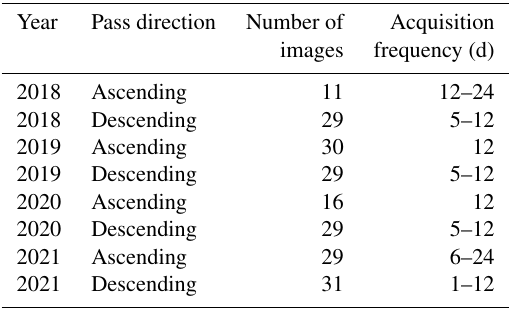
Table 2. The number of Sentinel-1 SAR images used for analysis by satellite pass